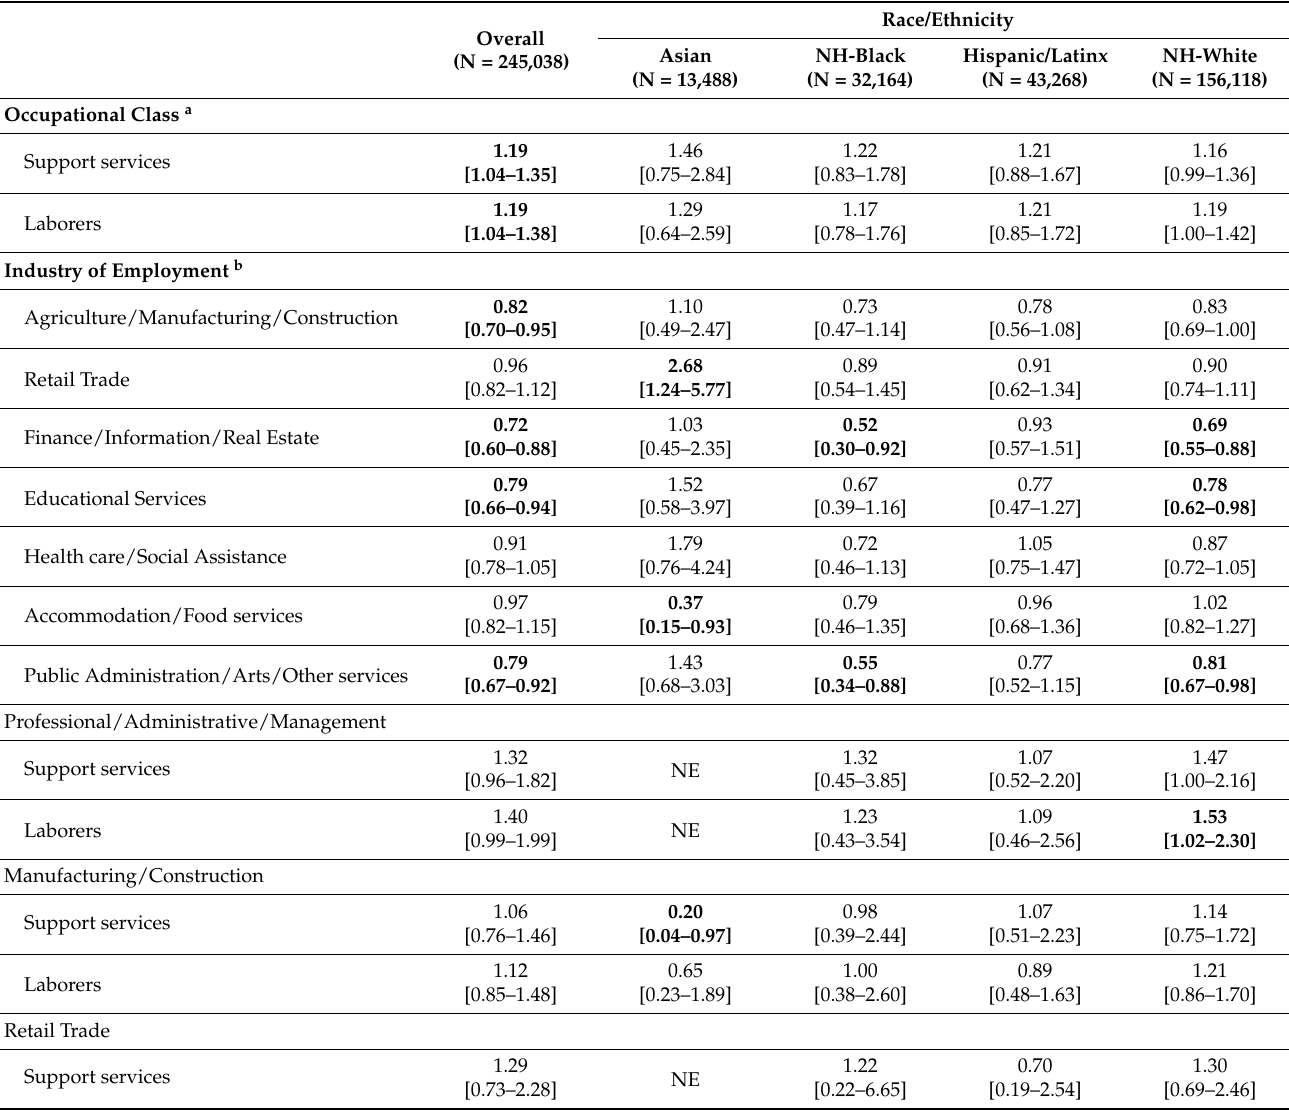
Table 2. Adjusted Prevalence Ratios (95% Confidence Intervals) for the Association Between Oc- cupational Class (compared to Professional/Management positions) and Industry of Employment (compared to the Professional/Administrative/Management Industry) and Serious Psychological Distress, Stratified by Race/Ethnicity, National Health Interview Survey, 2004–2018, (N = 245,038). Race/Ethnicity Overall Asian NH-Black Hispanic/Latinx NH-White (N = 245,038) (N = 13,488) (N = 32,164) (N = 43,268) (N =